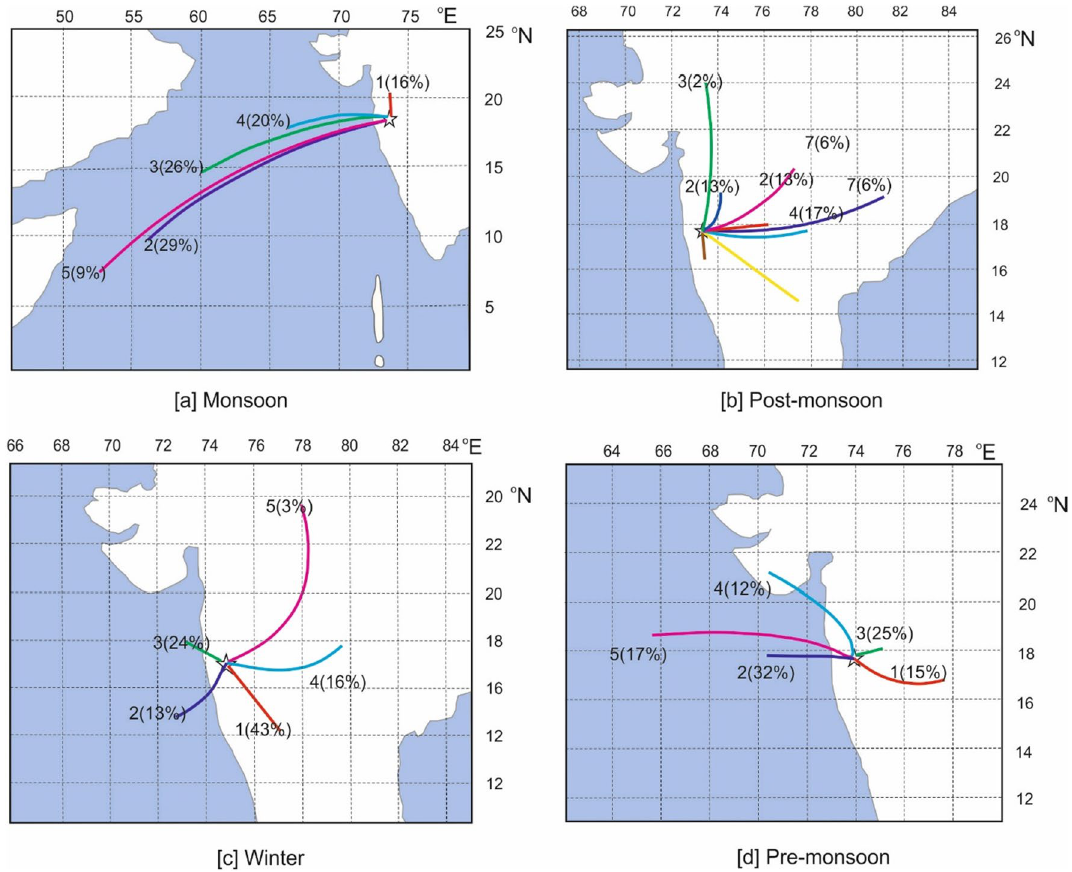
Figure 3. ( a – d ) 10-day back trajectories arriving at Sinhagad at a surface level during monsoon, post-monsoon, winter, and